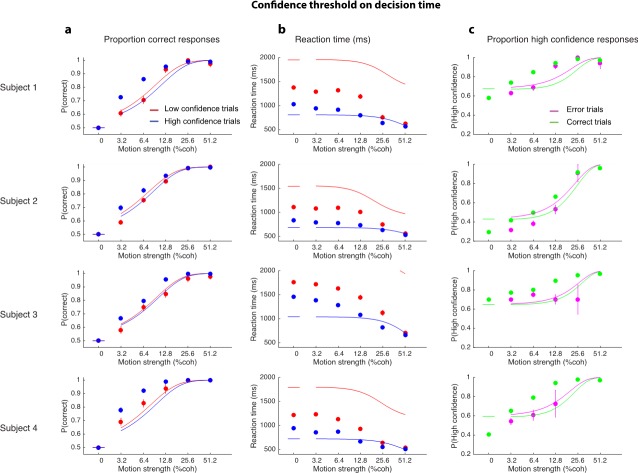
Fits to alternative model 2 that uses a threshold on decision time to assign confidence (shorter decision times are more confident to match the data) and ignores BoE.The striking failure in the middle column arises because for any criterion, the mean of all decision times greater than this criterion will be large and mean of the times less than this criterion will be small (n.b., the red curve for S3, middle column, is mostly off the graph; only the right end of curve is visible). The other qualitative failures are best appreciated by drawing on intuitions associated with a simpler diffusion model – with symmetric, flat bounds for right and left choices. This is mathematically identical to our competing accumulators but with perfect anti-correlation. In the simpler 1-dimensional model, (1) there is no balance of evidence; (2) the DV is at the level of the upper or lower bound at decision termination, (3) the proportion correct is independent of decision time, and (4) mean RT on correct and error choices are the same for any motion coherence. Based on point 3, we would expect the choice functions in the left column to be identical. They are not exactly the same because our model is a race between two negatively correlated but non-redundant accumulators, and in our particular instantiation (e.g., no reflecting lower bounds), this yields slightly faster errors, which are assigned higher confidence (left column). The same logic applies to the right column.